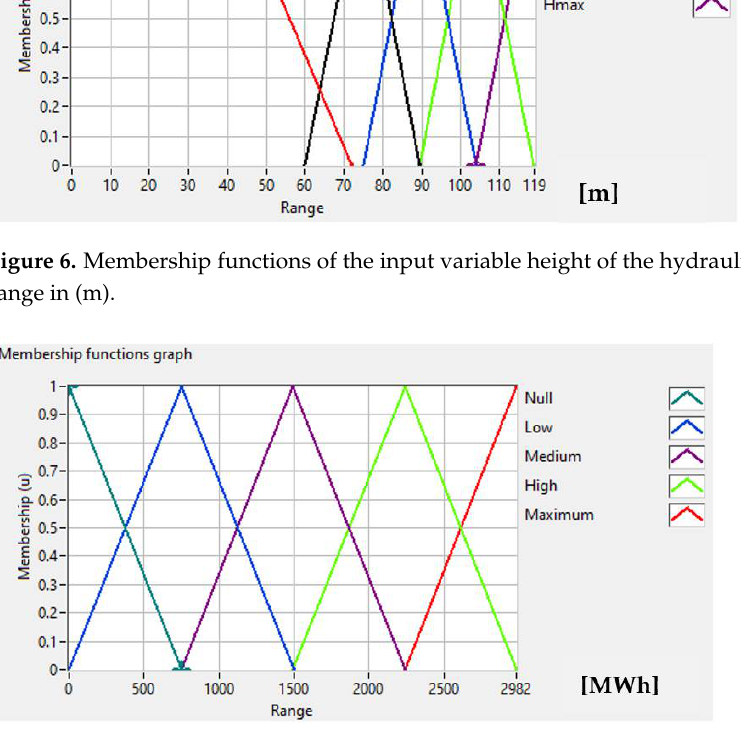
Figure 7. Membership functions of the wind power input variable to the hydraulic fuzzy system. X-axis range in (MWh).